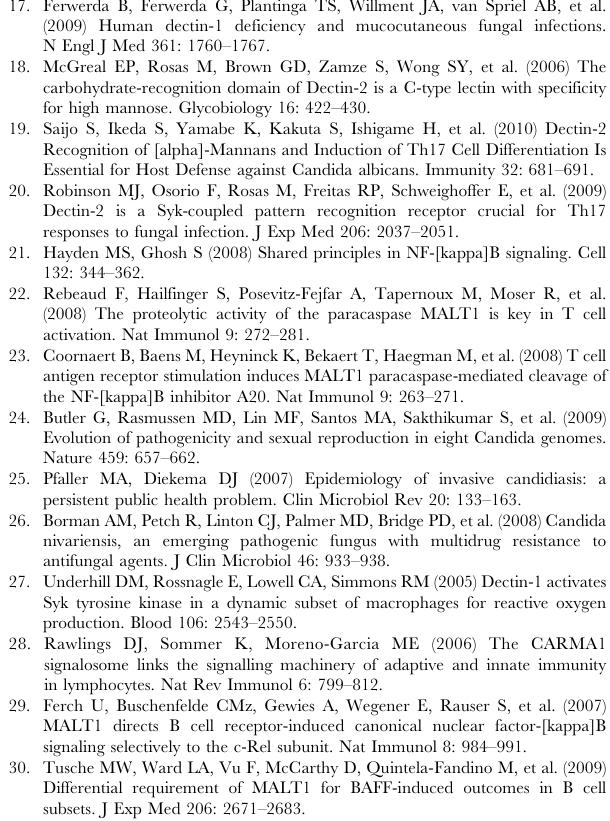
Figure S1 Silencing of Syk, CARD9, Bcl10, Malt1 and c-Rel in human primary DCs by RNA interference. Indicated proteins GAPDH and set at 1 in control siRNA-treated cells. Data are and I) or are representative of at least two independent experiments (B, D, F, H and J). Figure S2 LPS signaling is not affected by Syk, CARD9, Bcl10, Malt1 and c-Rel silencing. Quantitative real-time PCR of indicated mRNAs in curdlan-stimulated DCs after Syk, CARD9, Bcl10, Malt1 and c-Rel silencing by RNA interference (siRNA). Expression is normalized to GAPDH and set at 1 in curdlan- stimulated cells. Data are mean 6 s.d. of at least three independent experiments.